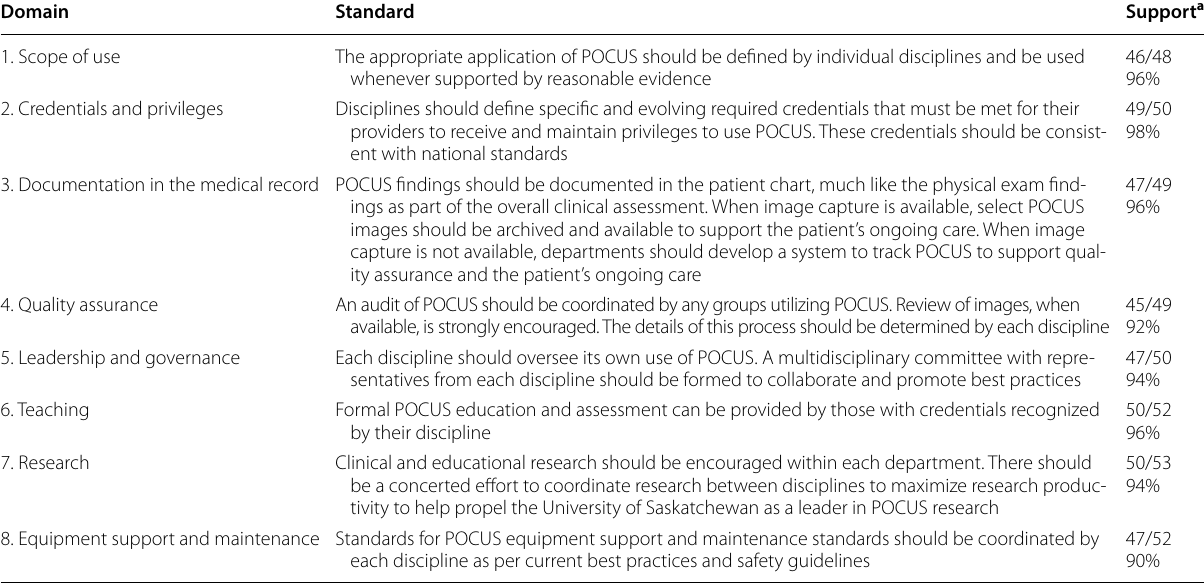
Table 3 Consensus domains and plenary session support for each of the standards within the multidisciplinary POCUS